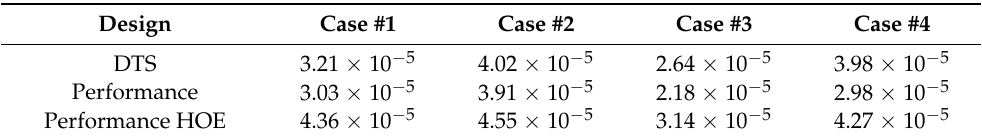
Table 5. ERL results of design scenarios for Case #1 to #4 (DTS, Performance, HOE (human and organizational